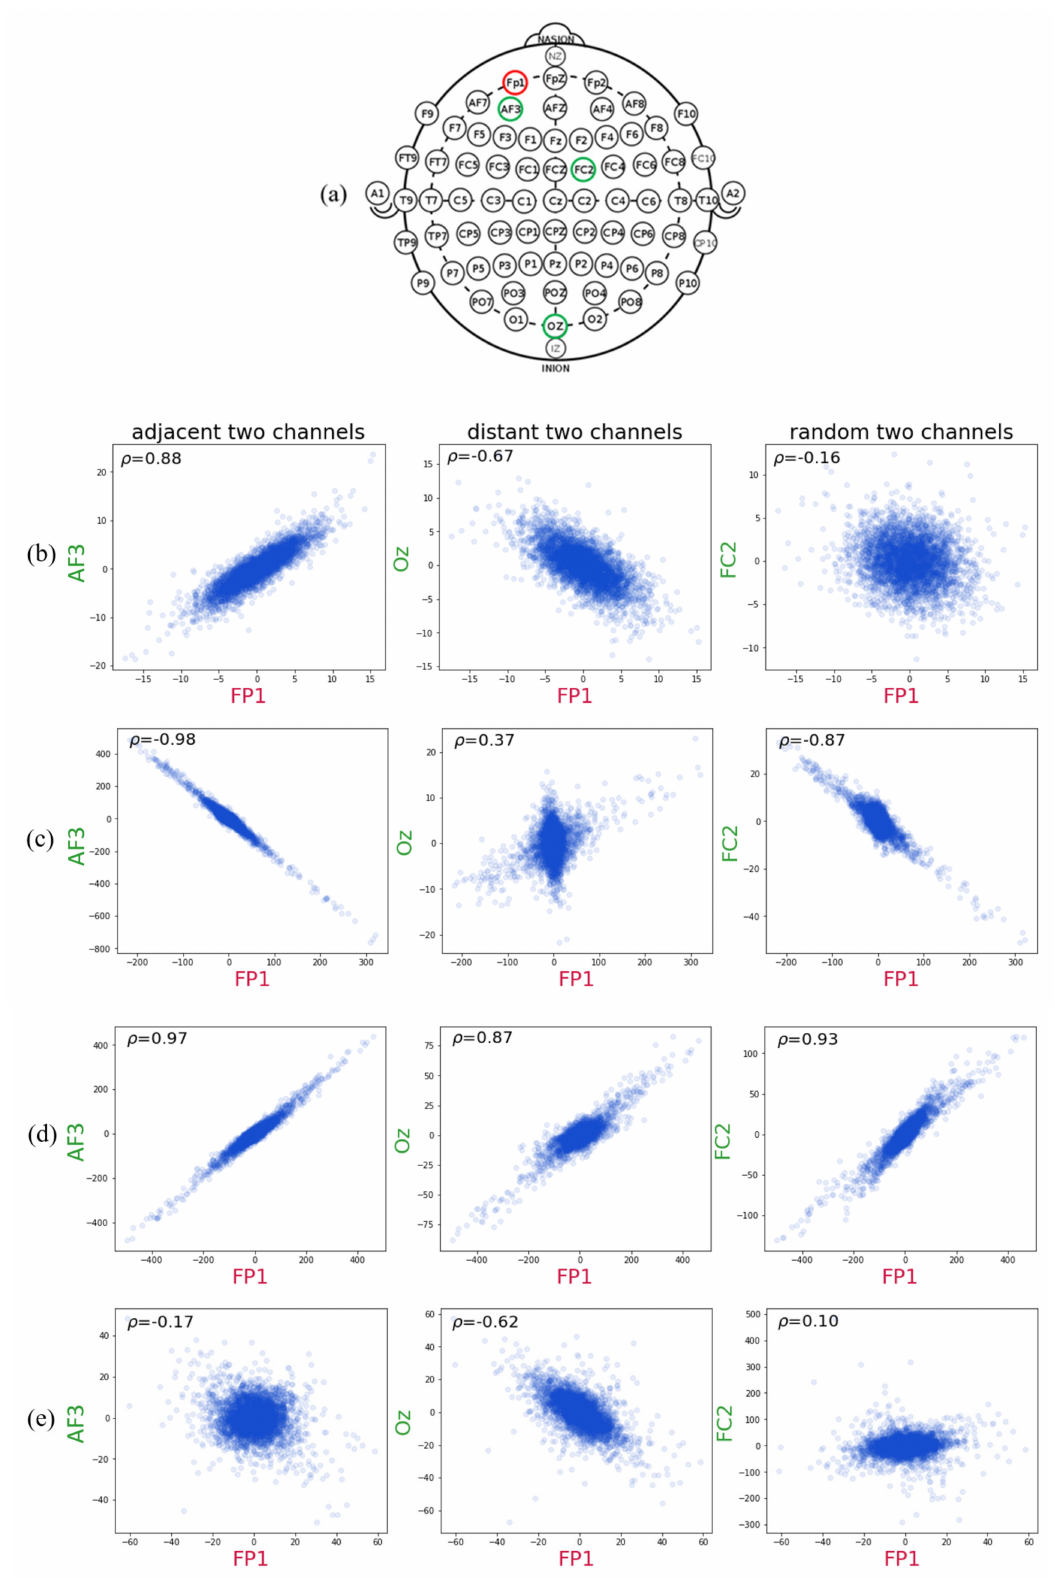
Figure 2. Some of the pairwise correlation between channels. ( a ) International 10–20 system for EEG electrode placement; the location of Fp1 is circled in red, AF3, FC2 and Oz are circled in green. ( b ) DEAP Subject 1, ( c ) DEAP Subject 2, ( d ) DEAP Subject 3, ( e ) DEAP Subject